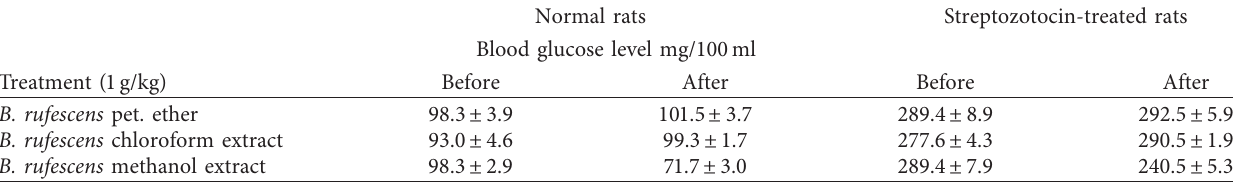
Table 2: In vivo antidiabetic assay of Bauhinia rufescens extracts.